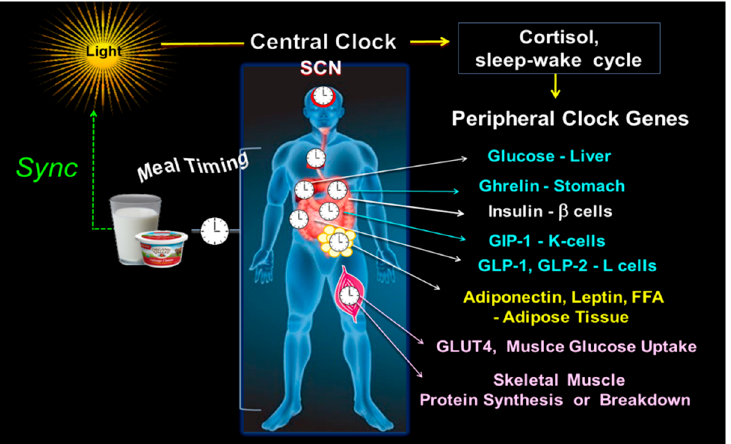
Figure 2. Central and peripheral clocks alignment. The illustration shows the central clock in SCN, responsive to light input, and peripheral clocks, activated by meal timing, both in synchrony. On the right side are some examples of the peripheral CGs outputs, i.e., the hepatic glucose production; ghrelin secretion in the stomach; b-cell insulin secretion; the intestinal K-cell secretion of GIP and L-cell secretion of GLP-1 and GLP-2; leptin and adiponectin in adipose tissue; GLUT4 driven muscle glucose uptake; and the muscle protein breakdown/synthesis.